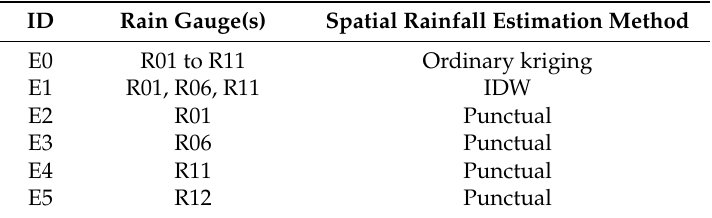
Table 4. Rainfall monitoring